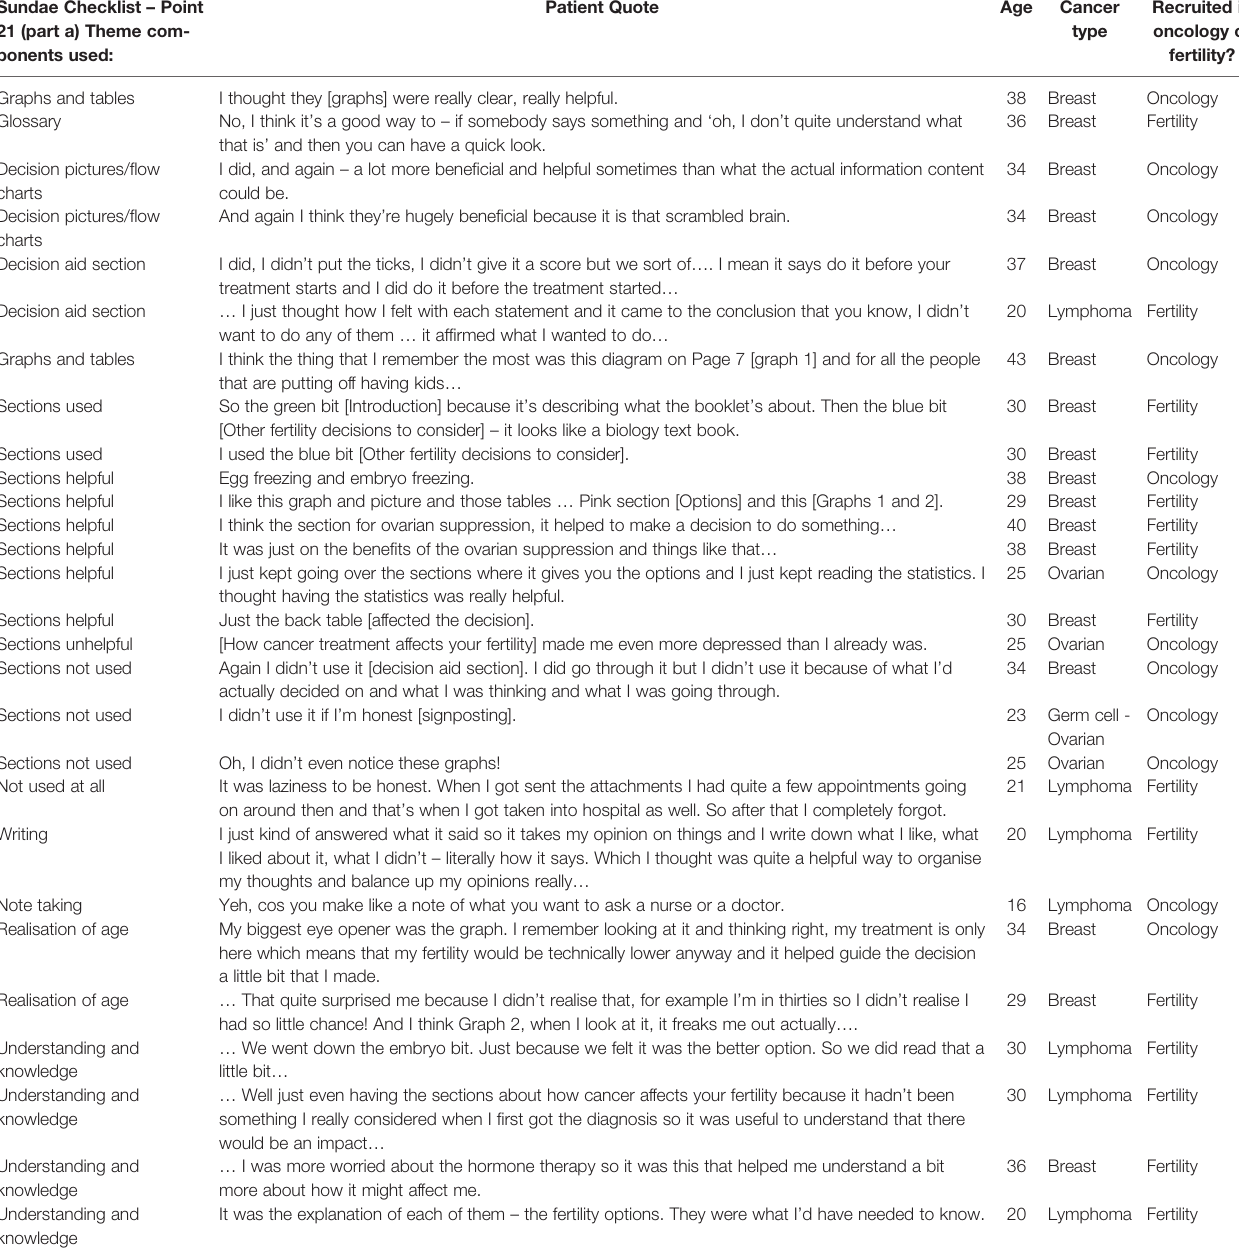
TABLE 6 | Which components of the CFM resource were used? Sundae Checklist – Point 21 (part a) Theme com- ponents